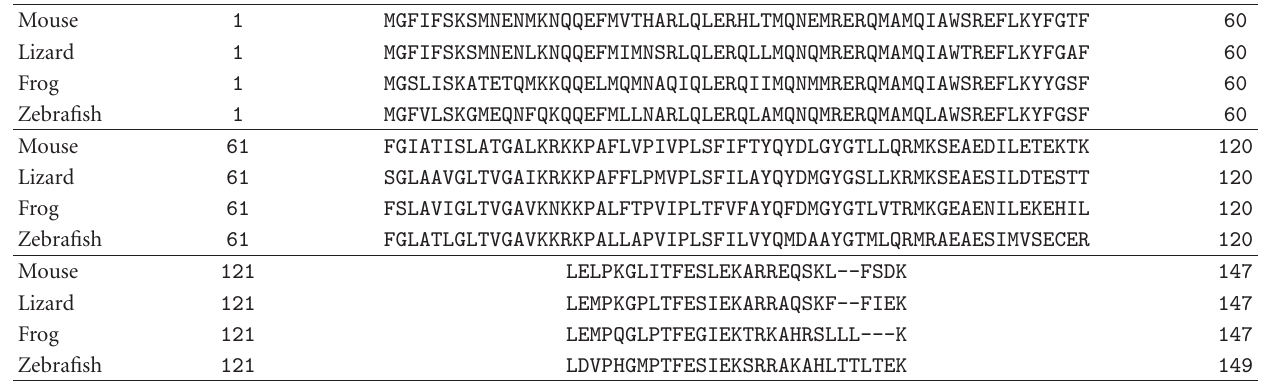
Table 2: Alignment of Mouse, Lizard (arborial), Frog (xenopus), and Zebrafish Plg-R KT